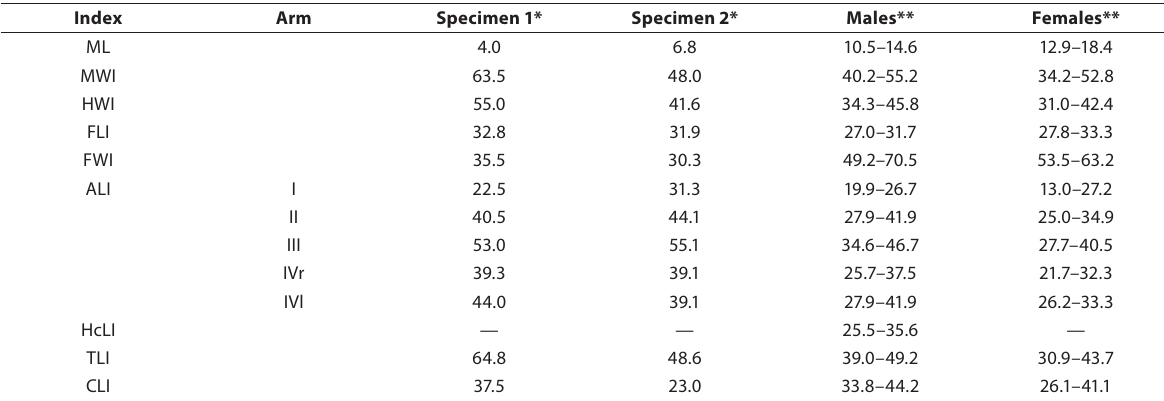
Table 2. Pickfordiateuthis vossi . Morphological indices (%) in: *this study, **holotype and paratypes from Brakoniecki (1996). ML = mantle length (mm). Following indices are in percentage (%) of the ML. MWI = mantle width index, HWI = head width index, FLI = fin length index, FWI = funnel width index, AL = arm length index for I, II, III, IV = arm I to IV respectively, r = right, l = left, HcLI = hectocotylus length index, TLI = tentacle length index, and CLI = tentacular club length